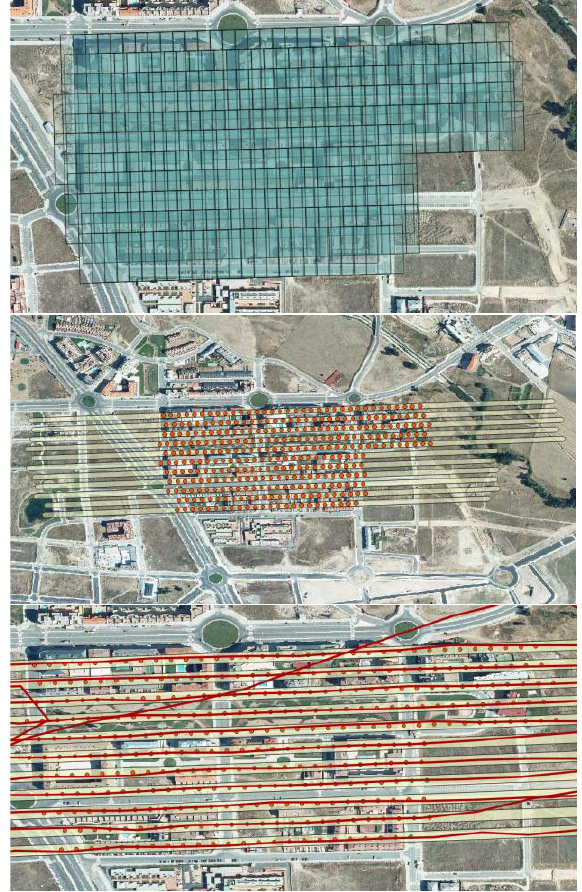
Figure 3: Example of flight planning: (Top) Areas captured by each image shot for the thermographic sensor. (Middle) Flight planning for the navigation of the aerial trike. (Bottom) GPS track after the aerial trike flight with the position of each image